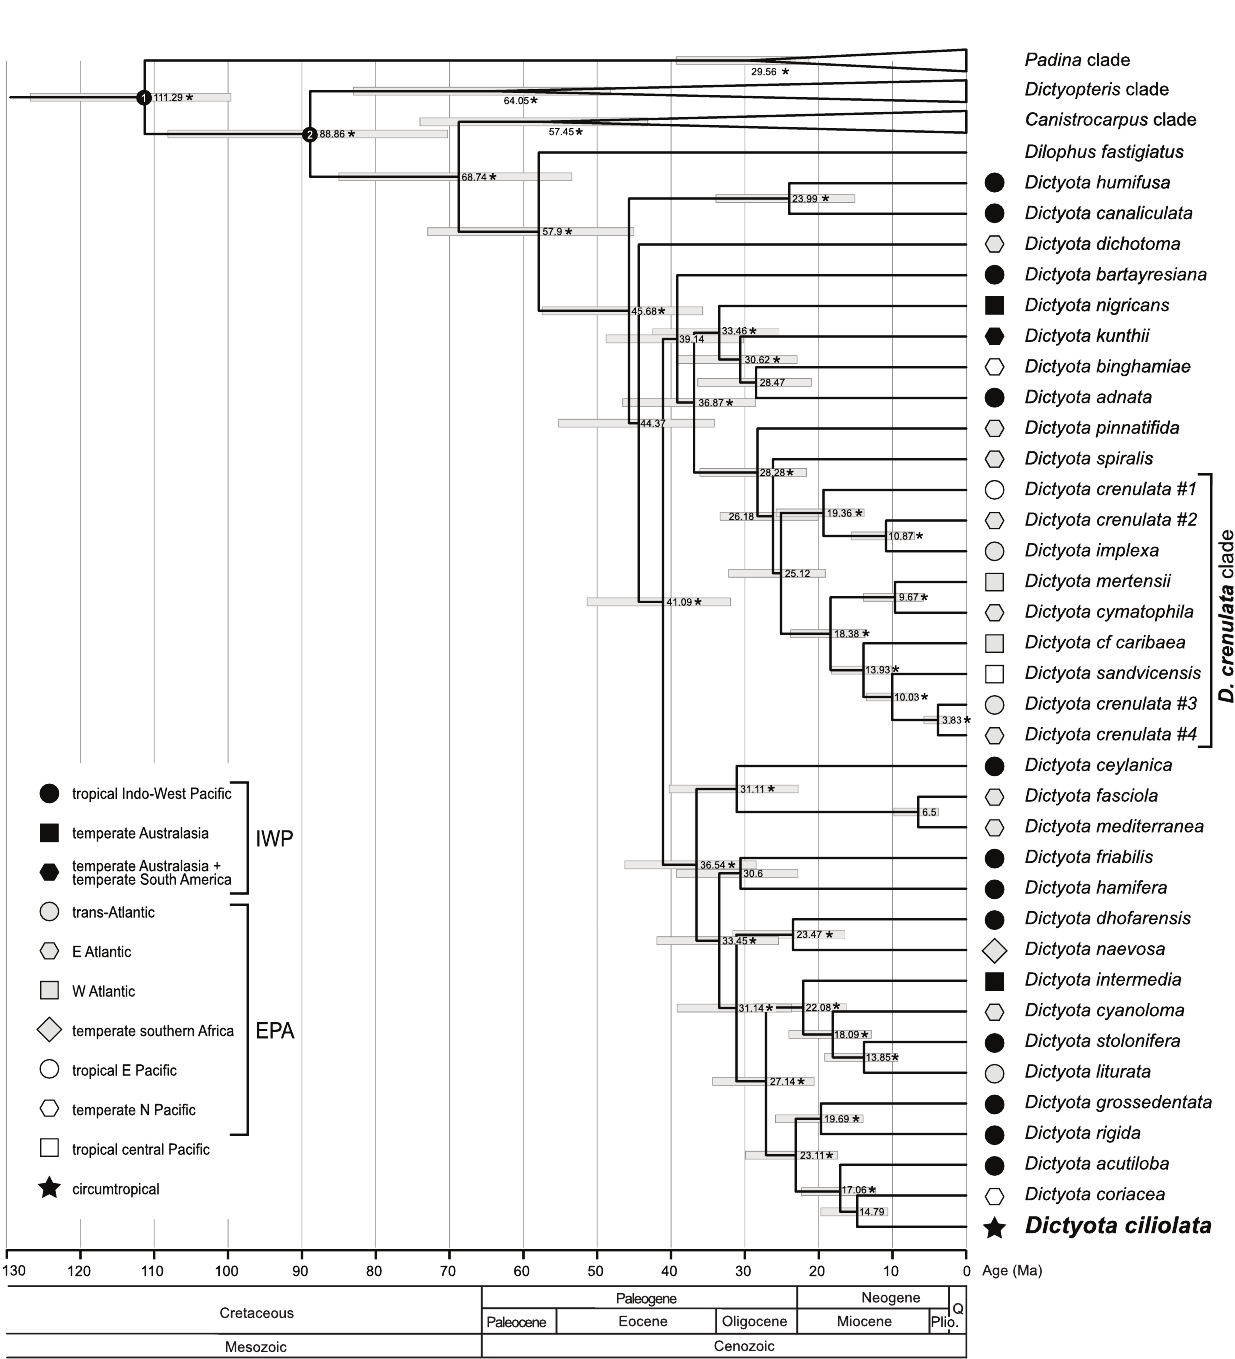
longitudinal range (R 2 =0.828), i.e. species with the highest thermal tolerance showed broader latitudinal and longitudinal ranges (e.g. D. implexa and D. ciliolata ) (Fig. 4). Discussion Species boundaries and geographic range Molecular screening of geographically disparate populations of a common tropical Dictyota species, D. crenulata , revealed a complex